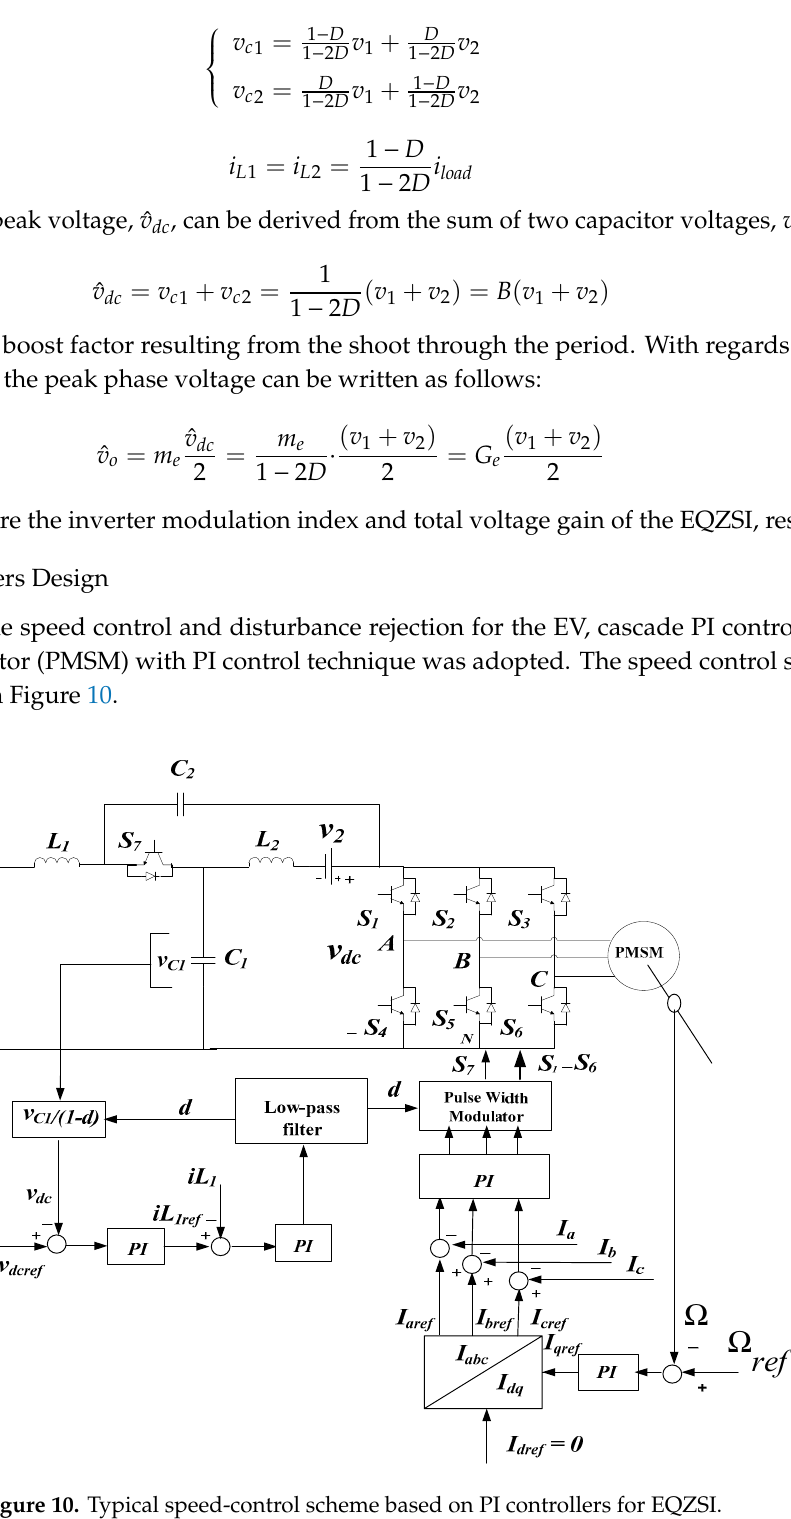
Figure 10. Typical speed-control scheme based on PI controllers for EQZSI.